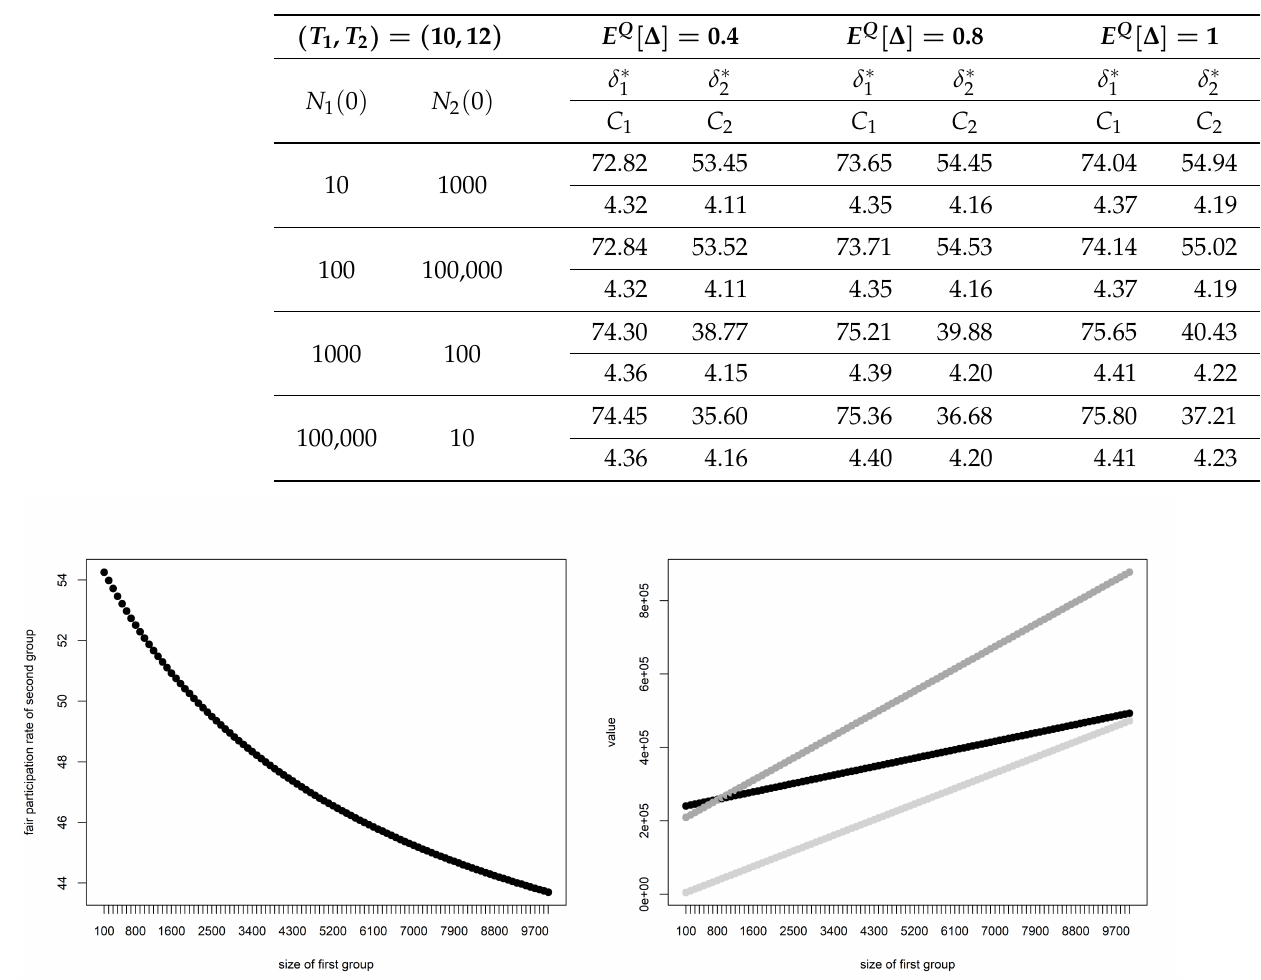
Table 6. Fair participation rates and certainty equivalent returns for Case 2 with ( T 1 , T 2 ) = ( 10,12 ) , different portfolio sizes with N 1 ( 0 ) (cid:54) = N 2 ( 0 ) and different values of E Q [ ∆ ] . All results are in percentage.